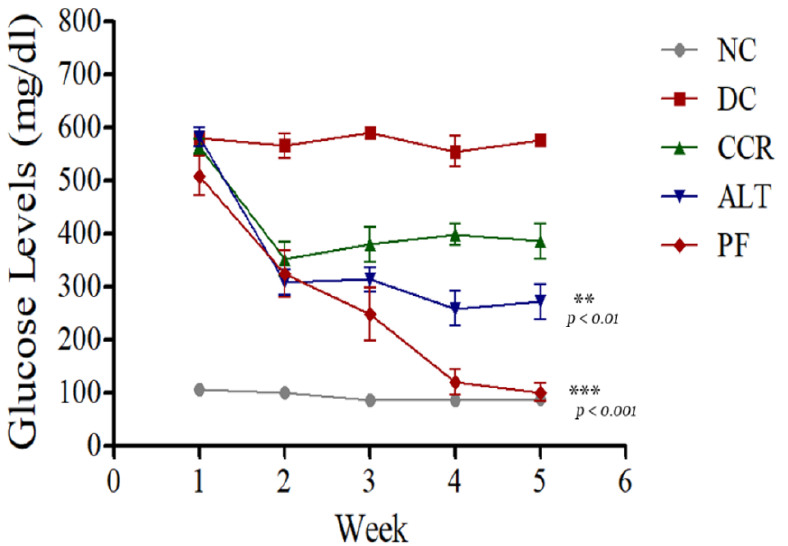
Figure 7. Effects of various intermittent fasting protocols on glucose levels: Data represent the mean ± SEM of the glucose content (** p < 0.01 and *** p < 0.001 vs. diabetic group). NC = Control, DC = Diabetes, CCR = Continuous calorie restriction, ALT = Alternate day calorie restriction, PF = Calorie restriction for 2